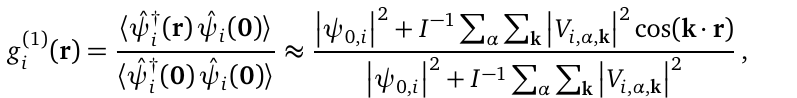
Figure 13: One-body coherence function g at fixed µ/ U = 1.4 across the (a) MI to (b) SF first-order